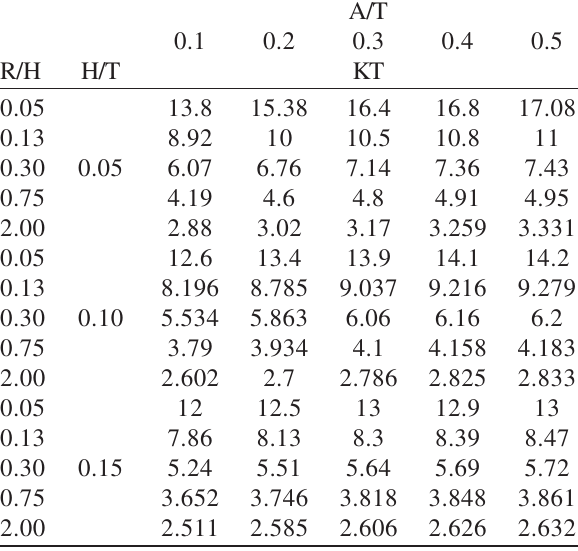
Tabla 2. Kt en función de los parámetrosgeométricos